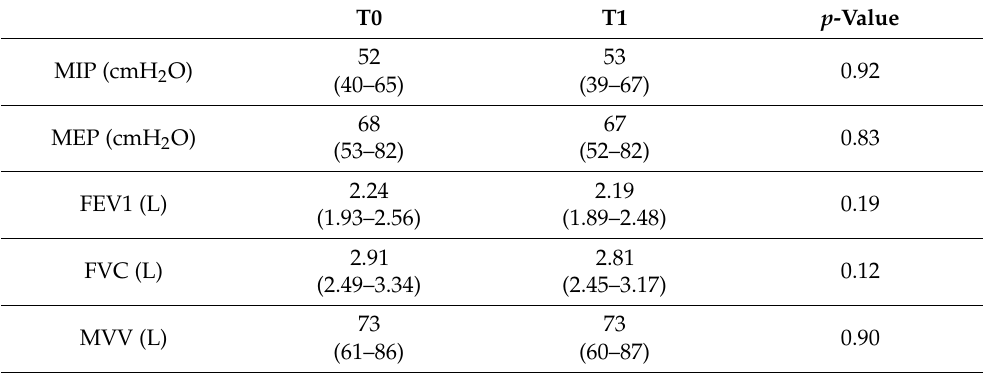
Table 2. Comparison between outcome measures from T0 to T1 in the entire population ( n = 22).